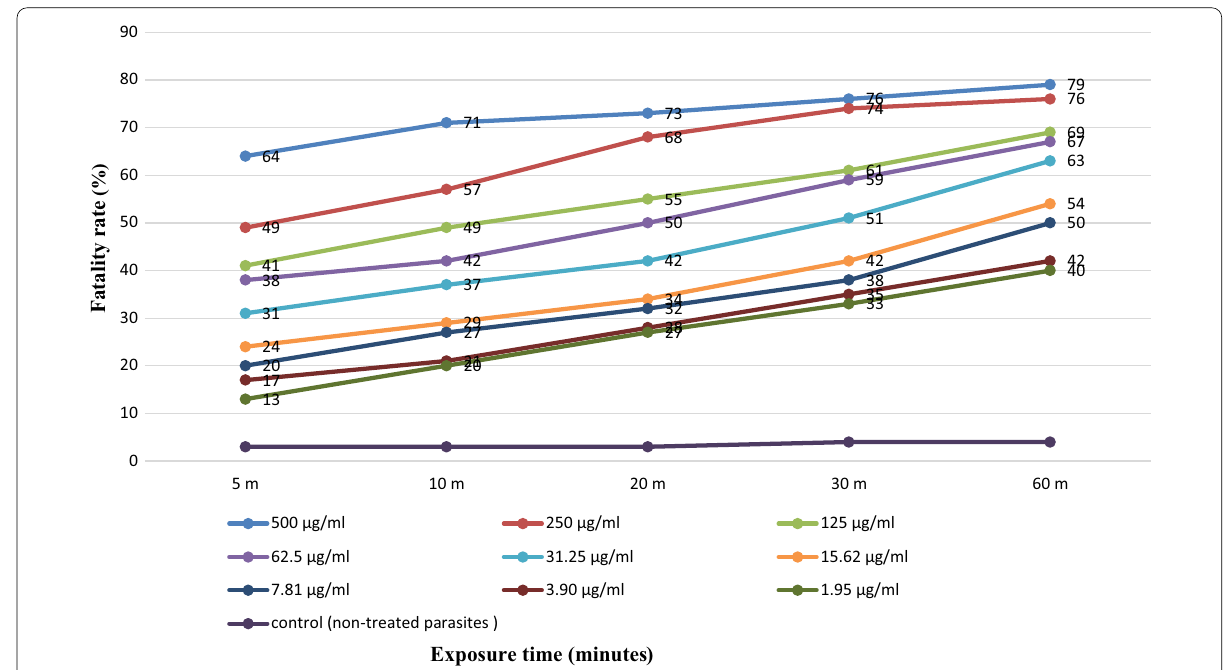
Fig. 6 Scolicidal effects of ethanolic extract of S. marianum with albendazole after exposure at different concentrations for 60 min. Each point represents the mean percentage of fatality rate